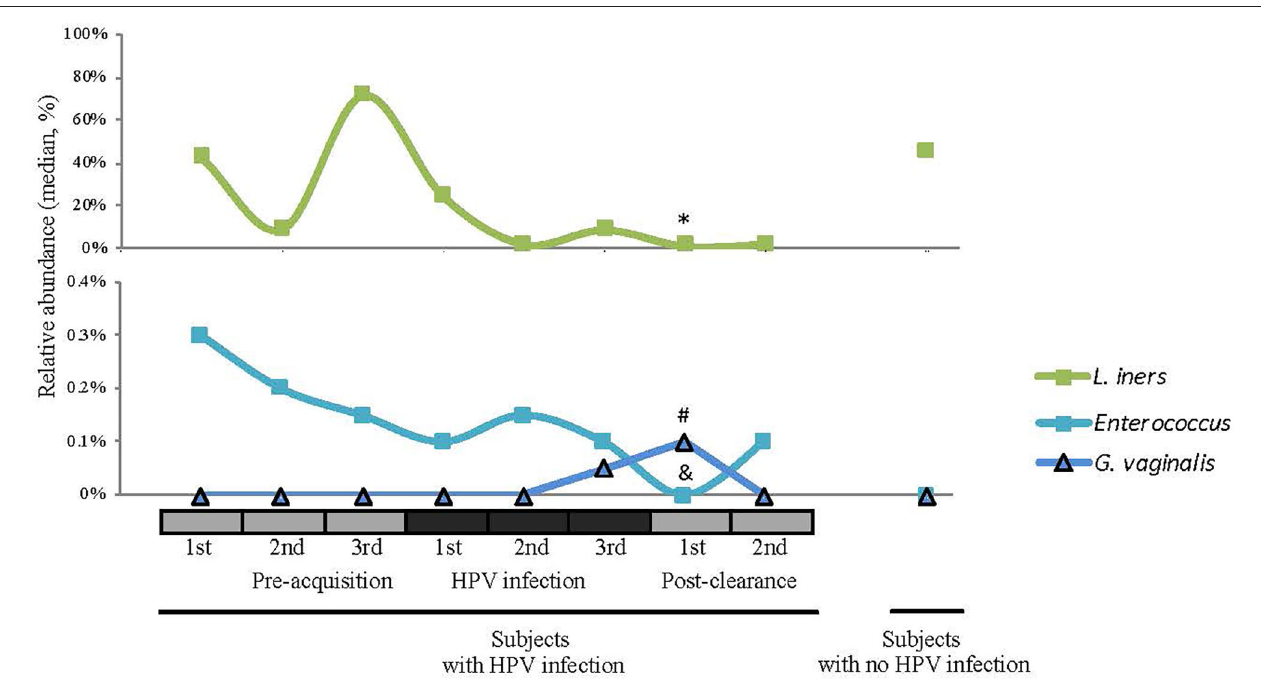
FIGURE 4 | Relative abundances of selected species ( L. iners, Enterococcus, and G. vaginalis) across different HPV 16 states. Wilcoxon rank-sum test was used in 8 pairwise testing of differences in the bacterial species between immediate post-clearance and the 8 other clinical states including women with no history of HPV. In the immediate post-clearance visit, L iners was lower than the 1st (* p = 0.06), 2nd (* p = 0.04), and 3rd (* p = 0.02) pre-acquisition visits, 1st (* p = 0.04), and 3rd (* p = 0.03) infection visits and in women with no history of HPV (* p < 0.001); G. vaginalis was higher than in the 1st infection visit ( # p = 0.02) and women with no history of HPV ( # p < 0.001); Enterococcus was lower in all pre-acquisition and infection visits as well as 2nd post-clearance visit (all & p < 0.001) but no difference was seen in women with no history of HPV.